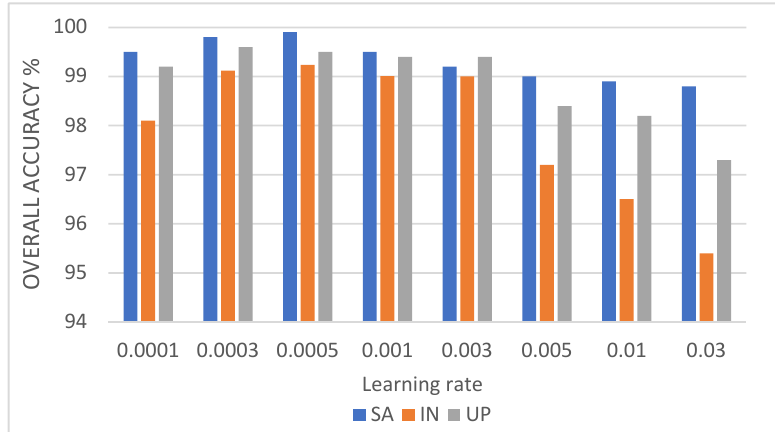
Figure 10. Overall classification accuracy per dataset under various learning rates.